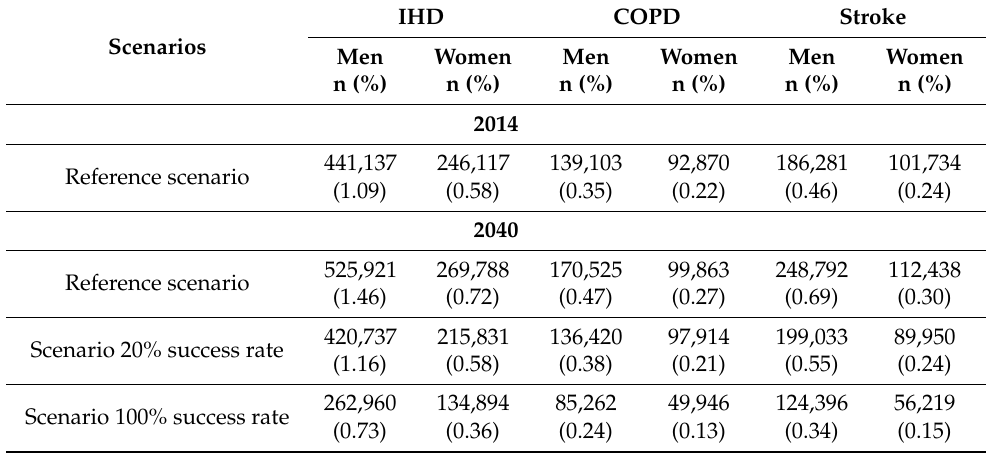
Table 3. Disease cases and population prevalences attributable to SHS exposure, Germany,